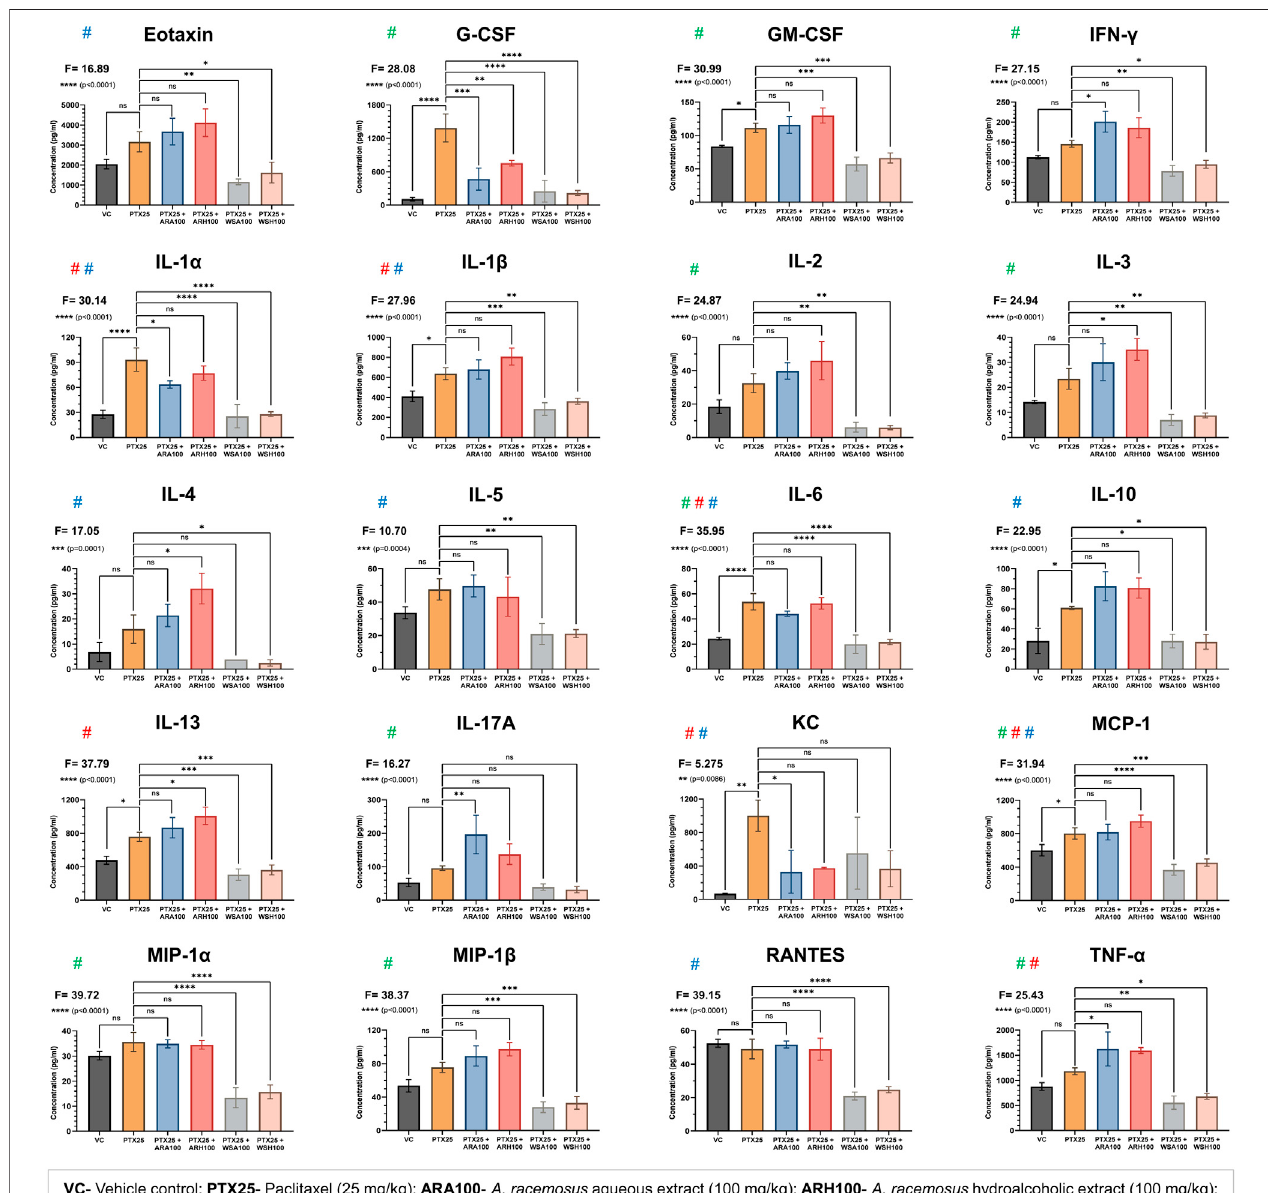
FIGURE 4 | Cytokine pro fi ling. The fi gure shows that ARA, ARH, WSA, and WSH extracts modulated the plasma levels of cytokines altered by PTX-administration with different statistical signi fi cance (** p = 0.0086 to **** p < 0.0001). The cytokines are categorized by their involvement in the biological processes such as hematopoiesis, in fl ammation, and morbidity signs (fatigue, peripheral neuropathy, hair loss, and pain in muscles and joints). PTX administration (25 mg/kg) for three consecutive days signi fi cantly altered the plasma levels of cytokines. Pre-administration of ARA (G-CSF, IL-1 α , and KC) and ARH (G-CSF) extracts (100 mg/kg) reversed the expressions of cytokines induced by PTX. Pre-administration of WSA and WSH extracts (100 mg/kg) normalized the PTX-altered cytokine levels comparable to that of VC group. The data points are represented as mean ± SD with n = 6.